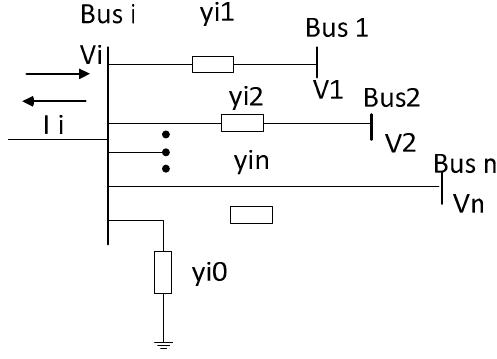
Figure 7. A typical bus in a power system network.